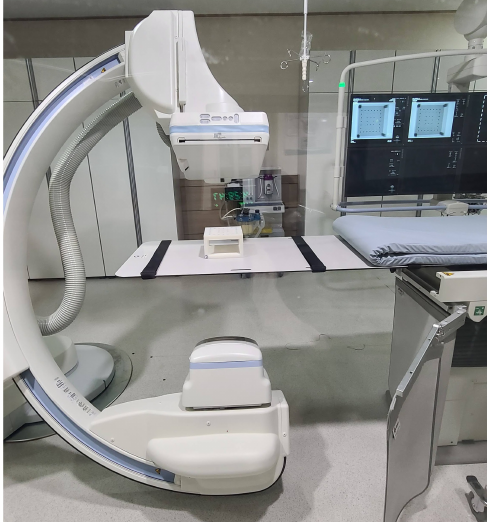
Figure 6. C-arm angio imaging device was applied to the experiment, which has the functions of 2D projectional X-ray imaging and CBCT